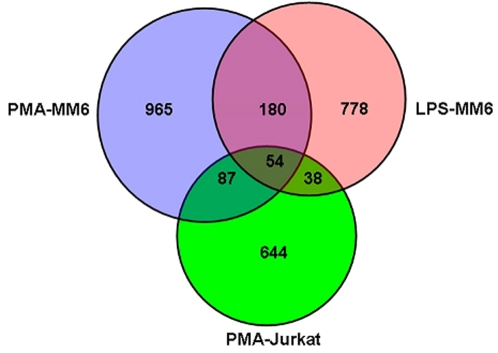
CTDGs.The Venn diagram represents the number of genes whose mRNAs were reduced >1.5-fold (p value<0.05) by Cyclin T1 depletions. Cyclin T1-dependency was observed for 965 of the PMA-inducible genes in MM6 cells, 778 of the LPS-inducible genes in MM6 cells, and 644 of the PMA/ionomycin-inducible genes in Jurkat cells. The number of genes in intersections of gene sets is indicated.